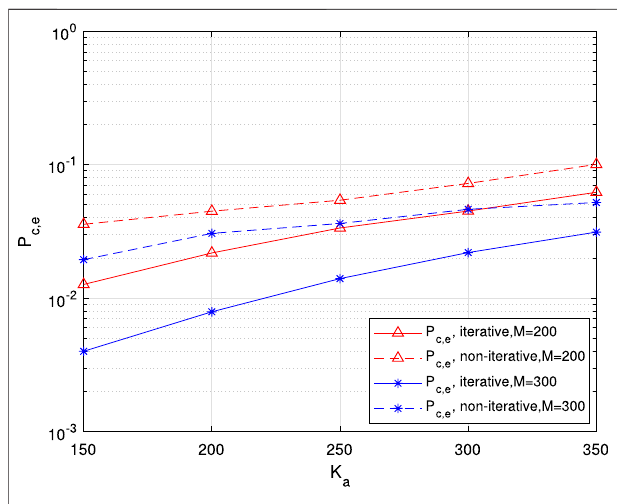
FIGURE 13 | Per-user error probability for common information as a function of the number of active users.